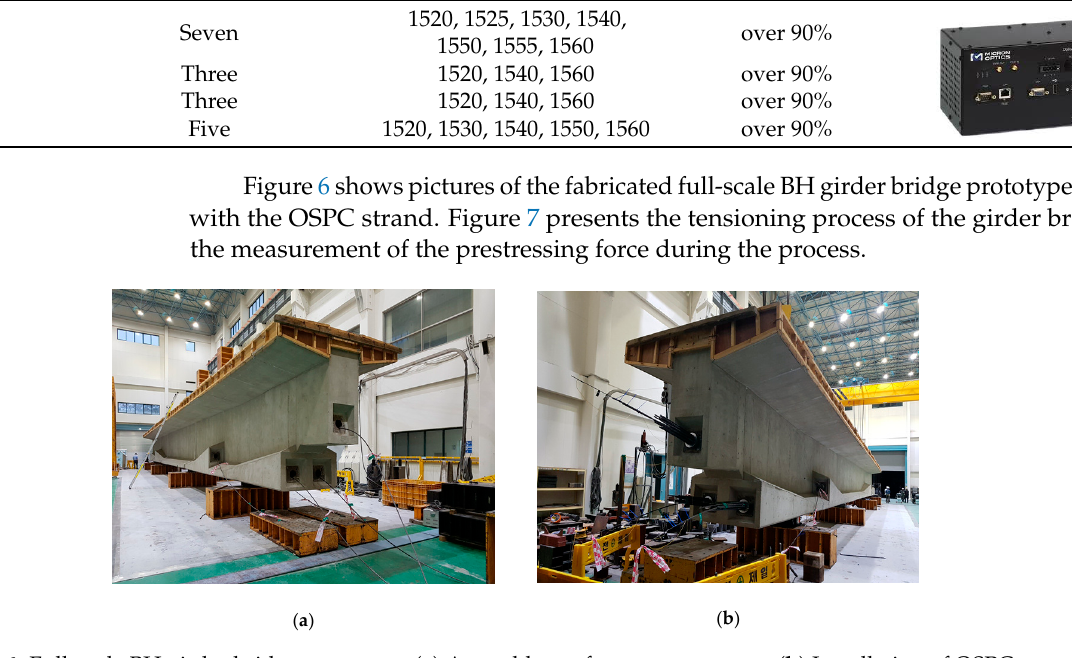
Figure 6. Full-scale BH girder bridge prototype: ( a ) Assemblage of precast segments; ( b ) Installation of OSPC strands.